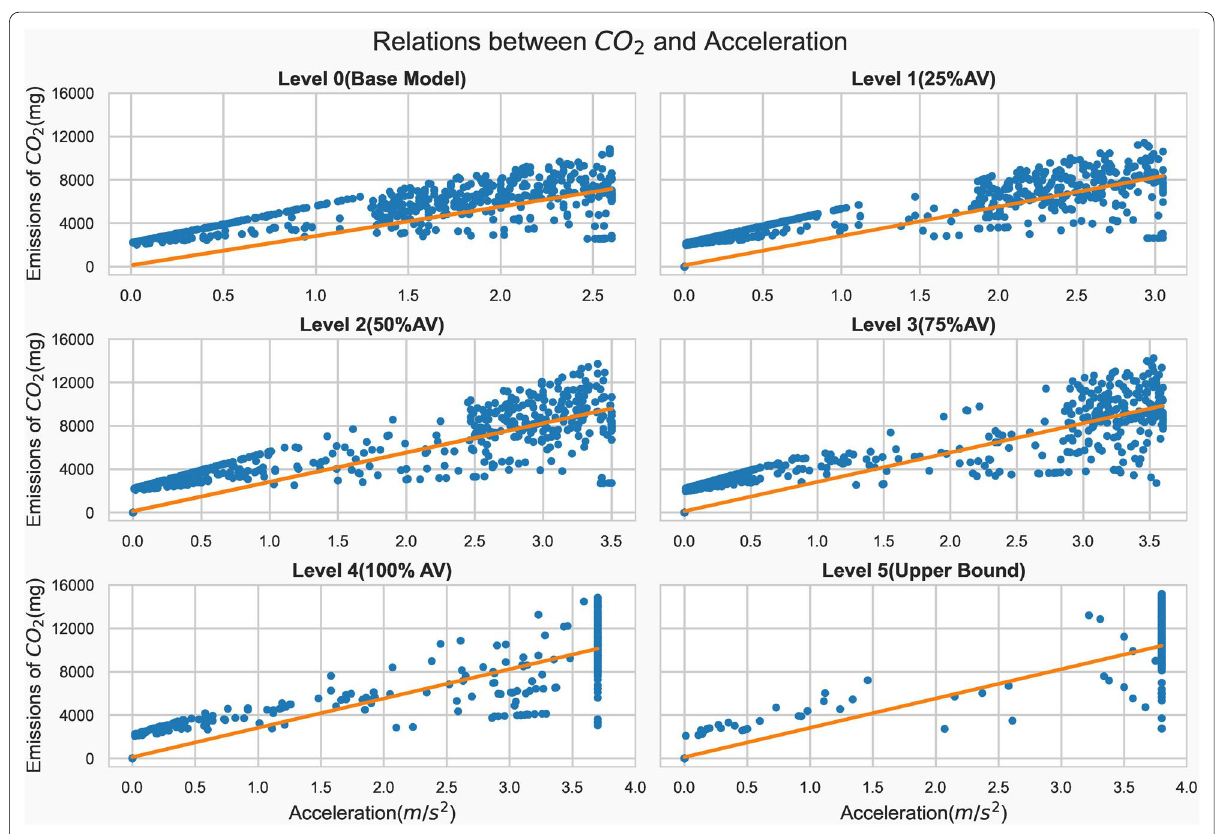
Fig. 6 Carbon dioxide emissions and acceleration scatter plots (Source: